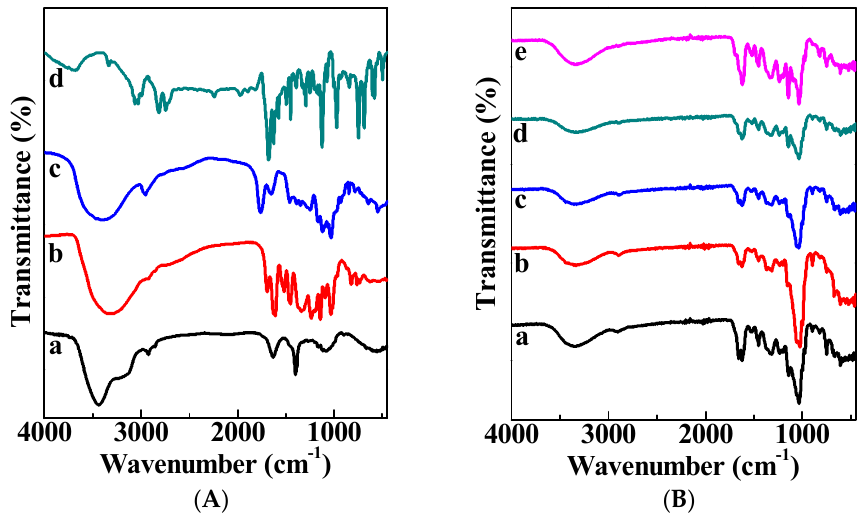
Figure 3. FTIR spectra of PC composite films. ( A ) cellulose (a), tea polyphenols (b), cinnamaldehyde (c), and pectin (d); ( B ) PC 1 (a), PC 2 (b), PC 3 (c), PC 4 (d), PC 5 (e).